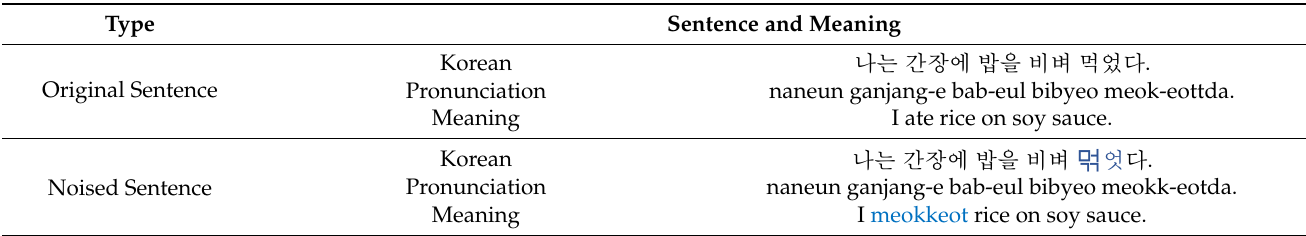
Table 6. Example of Heterograph Noising Rules.